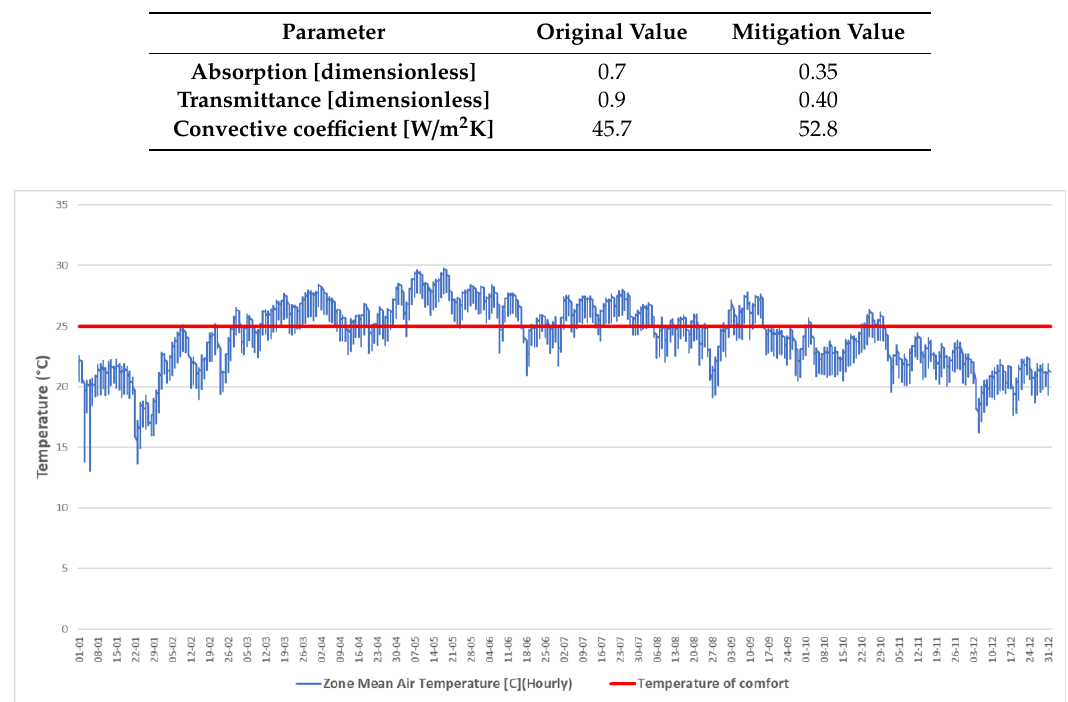
Figure 17. Annual indoor temperatures considering three urban approaches to decrease the UHI effect.